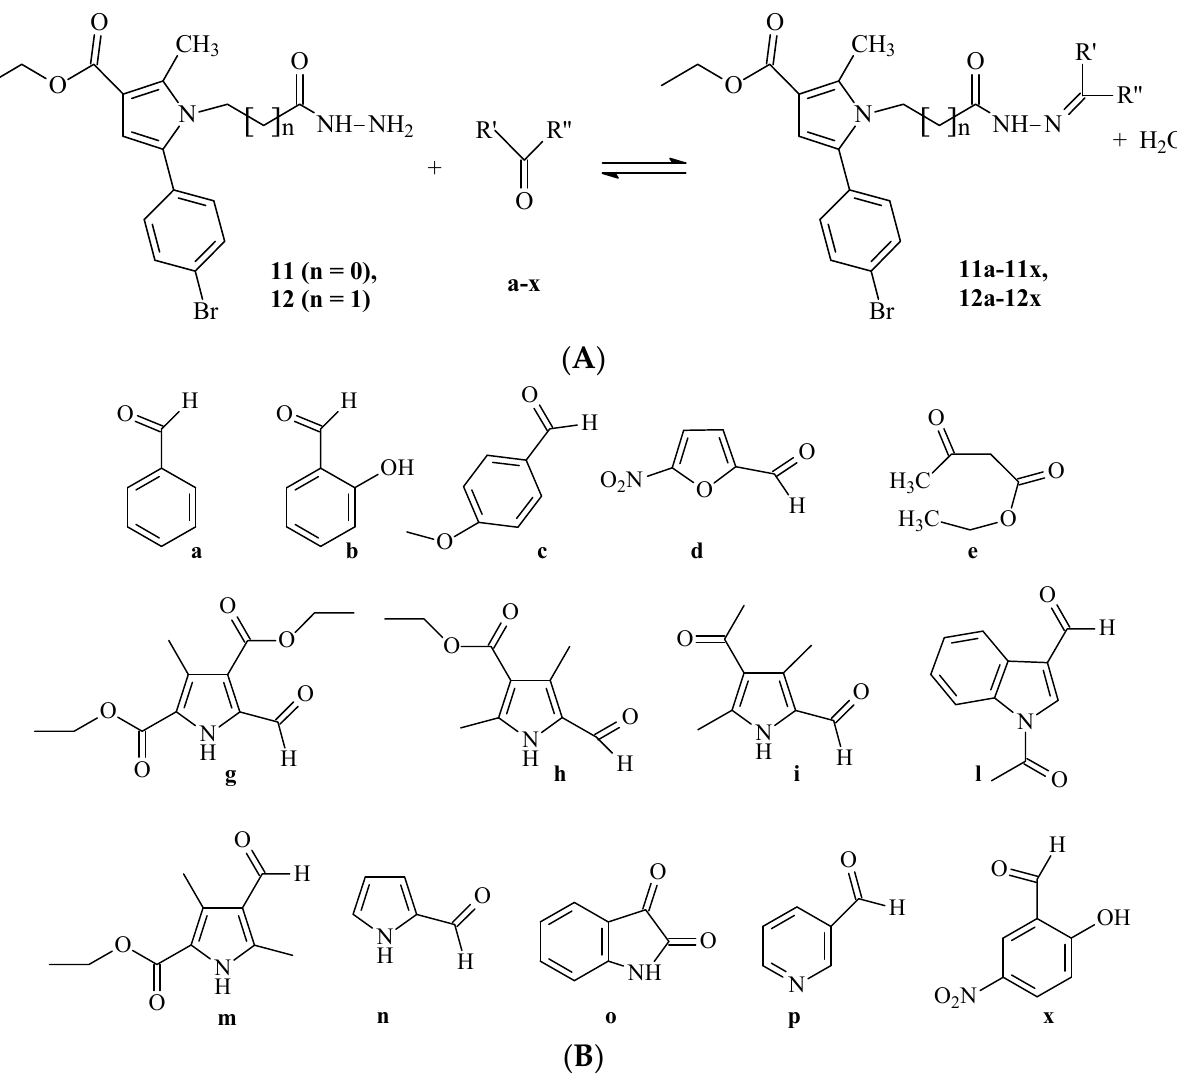
Figure 1. General structures of the compounds 11 and 12 and synthesis of hydrazones 11a – 11x and 12a – 12x ( A ), and structures of the corresponding carbonyl partners ( a – x ) ( B ).